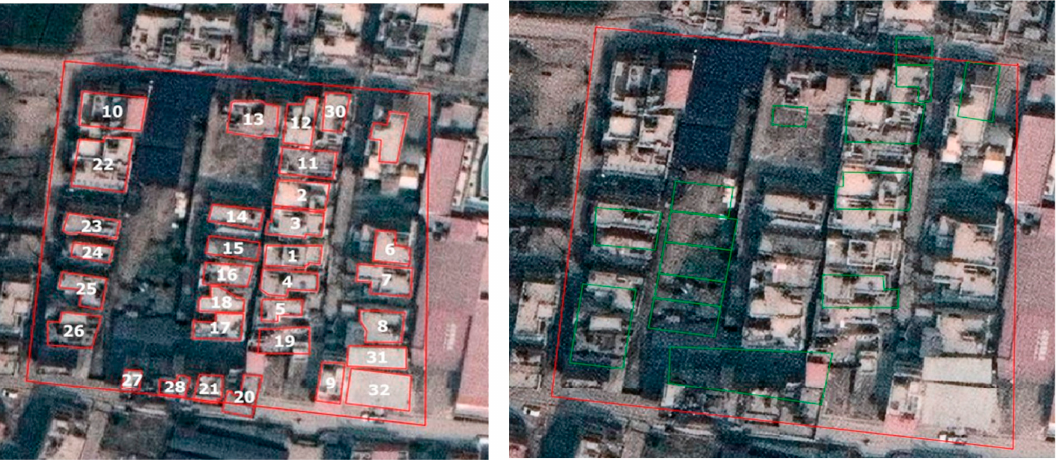
Figure 3. Manual digitization with house numbers ( right ), OSM polygon extraction ( left ) (Satellite Imagery of the study area from Google Earth TM ).